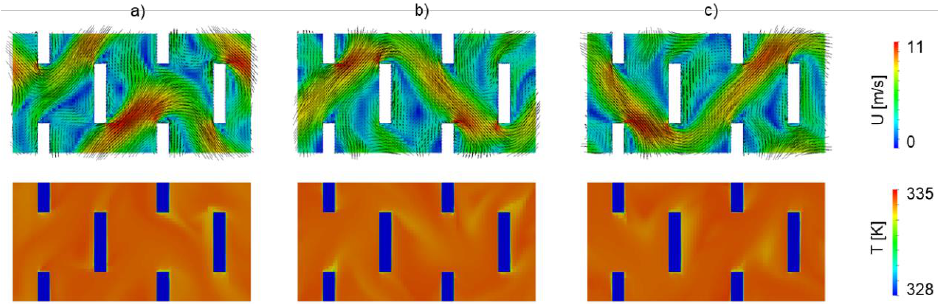
Figure 9. Time evolution of the instantaneous flow field with average velocity U = 2 m / s and momentum source direction α = 0 ◦ . The time interval between the frames ( a )–( c ) is ∆ t = 0.5